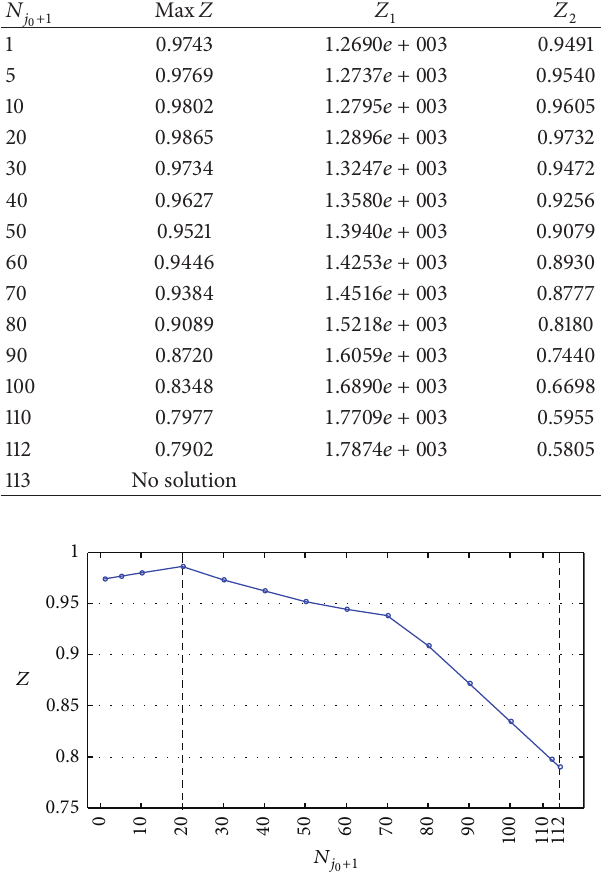
With the data in Table 5 plotted, Figure 5 is obtained. Figure 5 and Table 5 indicate the following